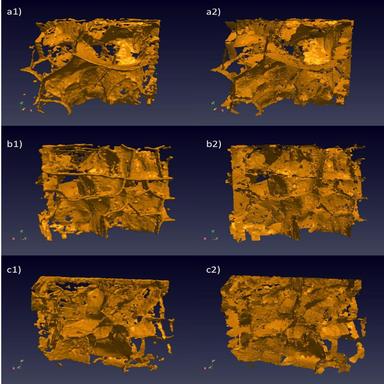
3 views of the reconstructions for sample TC69 are shown. The z-axis is the scan direction and the x-axis is the sintering (or TT) direction. The renderings on the left are from the volume reconstruction method (two-manifold). The renderings on the right are from the surface reconstruction (non-manifold). The length in the z-direction is approximately 3.2 mm.